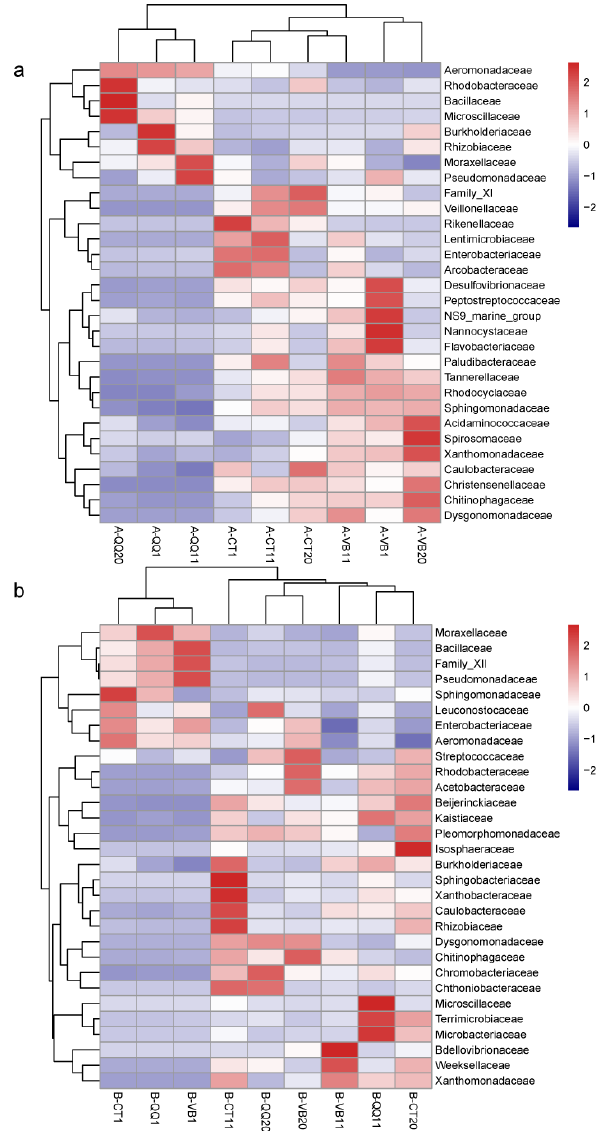
Figure 7. Heatmaps of the relative abundance for the top 30 bacteria grouped at the family level. ( a ) A-QQ, A-VB, and A-CT represent activated sludge with quorum quenching (QQ) beads, vacant beads, and no beads, respectively. ( b ) B-QQ, B-VB, and B-CT represent biofilms on membranes with QQ beads, vacant beads, and no beads, respectively. Numbers 1, 11, and 20 indicate the sampling time in days from each bioreactor. The color bar indicates intensity of each family in corresponding sample. Darker red indicated higher richness of certain family. Hierarchical cluster was shown on the left. Sample cluster (shown on the top) was created based on their community structure similarity.